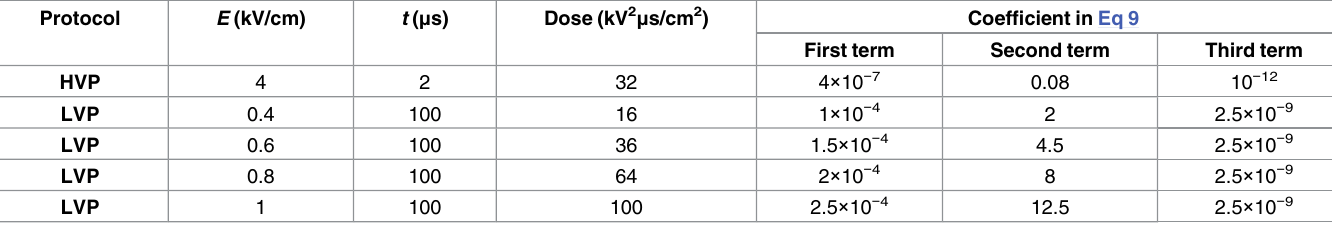
Table 6. Pore sizes resulting from electric force by different pulsation protocols.